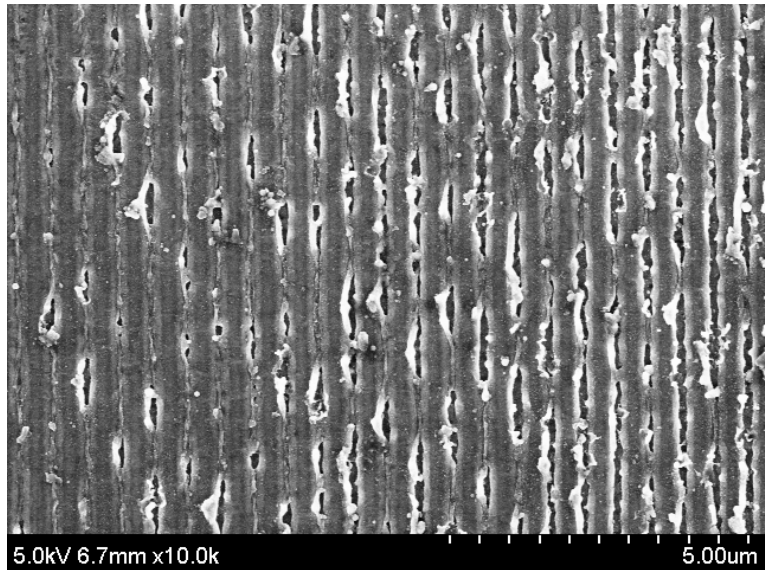
Figure 7. Damage morphology showing preferential damage of grid ridge at 0.95 J/cm 2.